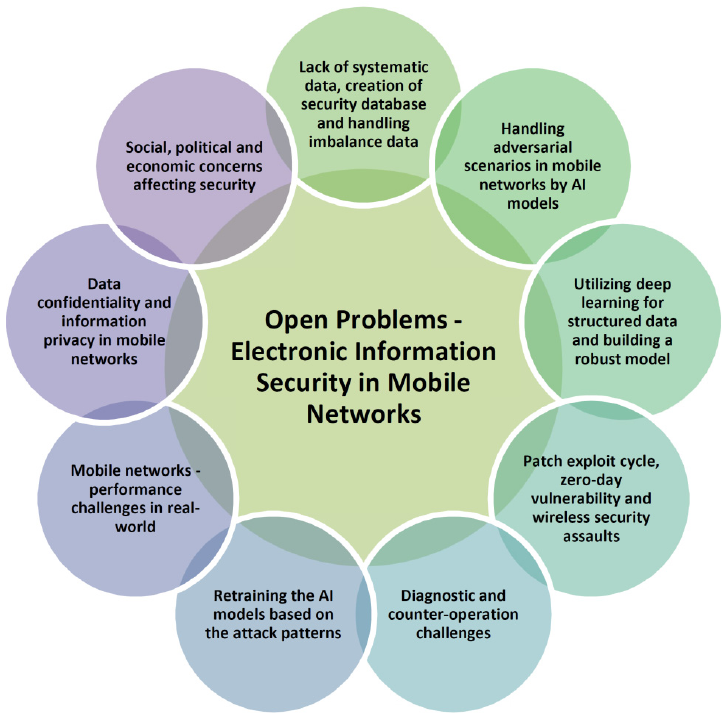
Figure 10. Electronic information security in mobile networks–open problems.